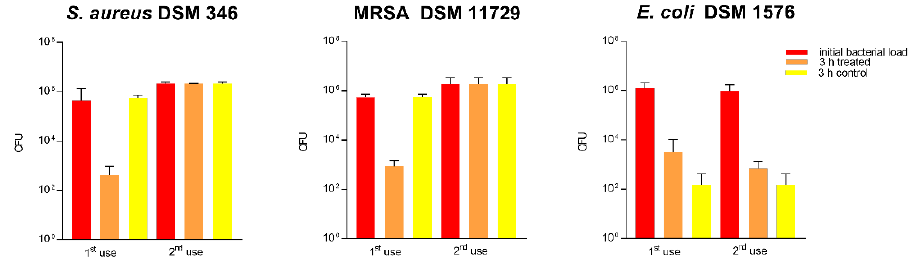
Figure 10. Quantification of viable bacteria using a dry assessment at first use and at second use. The results of two independent experiments are shown. A volume of 10 µL of bacterial inoculum was dried under standard conditions on the 2.5% Cu(NO 3 ) 2 -containing sol–gel surface, as well as a sol–gel surface without additive (control), and the experiment was repeated twice after wiping down the surfaces with 70% ethanol. The initial number of bacteria was quantified immediately after inoculation and after 3 h of incubation. Mean numbers of bacteria per surface (CFU) are displayed on a logarithmic scale with error bars indicating the standard deviation of the respective means. The threshold for achieving a mean reduction of three log from the initial bacterial inoculum determines the efficacy of the presumed antibacterial surfaces.